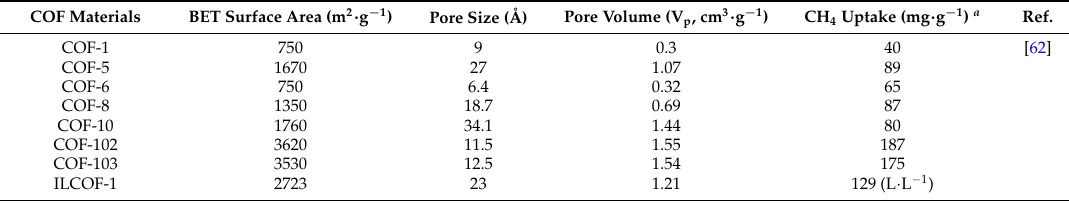
Table 2. BET surface area, porosity parameters and CH 4 capture of selected COFs.